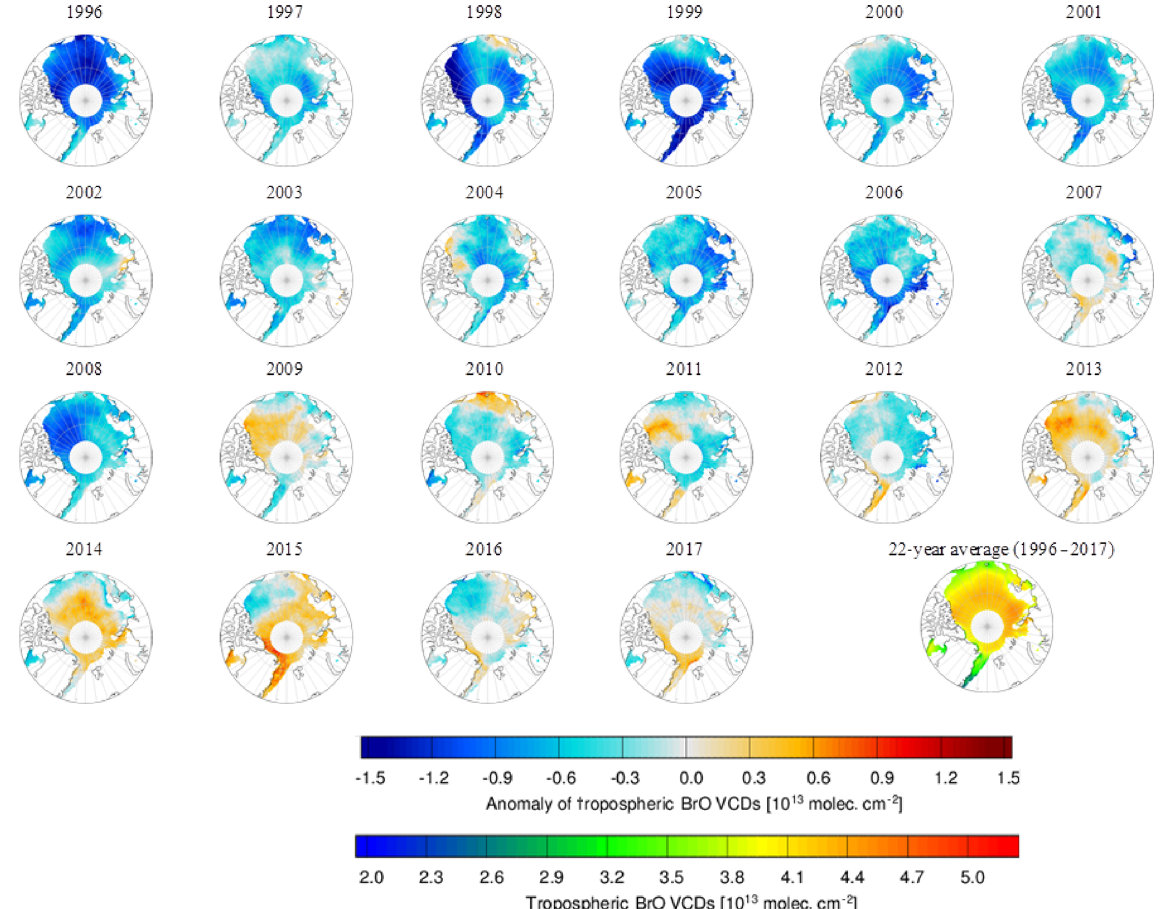
Figure 10. Anomaly maps of polar spring (MAM) tropospheric BrO VCDs (10 13 moleccm − 2 ) over sea ice. From every MAM average, the 22-year average (1996 to 2017, shown at the bottom right of row four) of tropospheric BrO VCDs was subtracted.